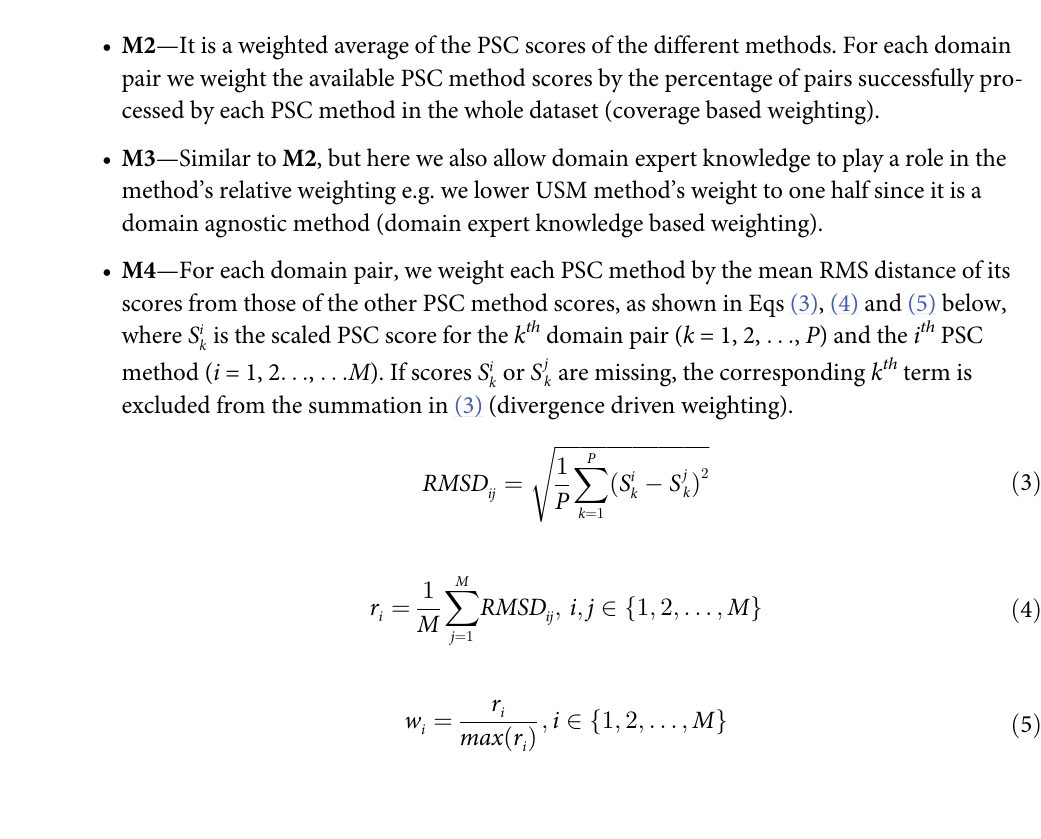
PSC scores. Base PSC scores calculation Pairwise scores for all PSC methods are first converted to dissimilarities (with value higher when domains in the pair are more different). PSC scores scaling A Logistic Sigmoid scheme is used to scale scores to ensure equal con- tribution of PSC methods towards the consensus MCPSC scores calculation. Given the base dissimilarity score ( X ) for a PSC method, its scaled version ( S ) is obtained using Eq (1) below, where μ and σ are the mean and standard deviation respectively over all scores X for that method. Effectively, the dissimilarity scores are first autoscaled (to make the different PSC method scores comparable) and then the logistic sigmoid is applied. As a result, at the end we obtain similarity scores ( S ) in the range 0 to 1.